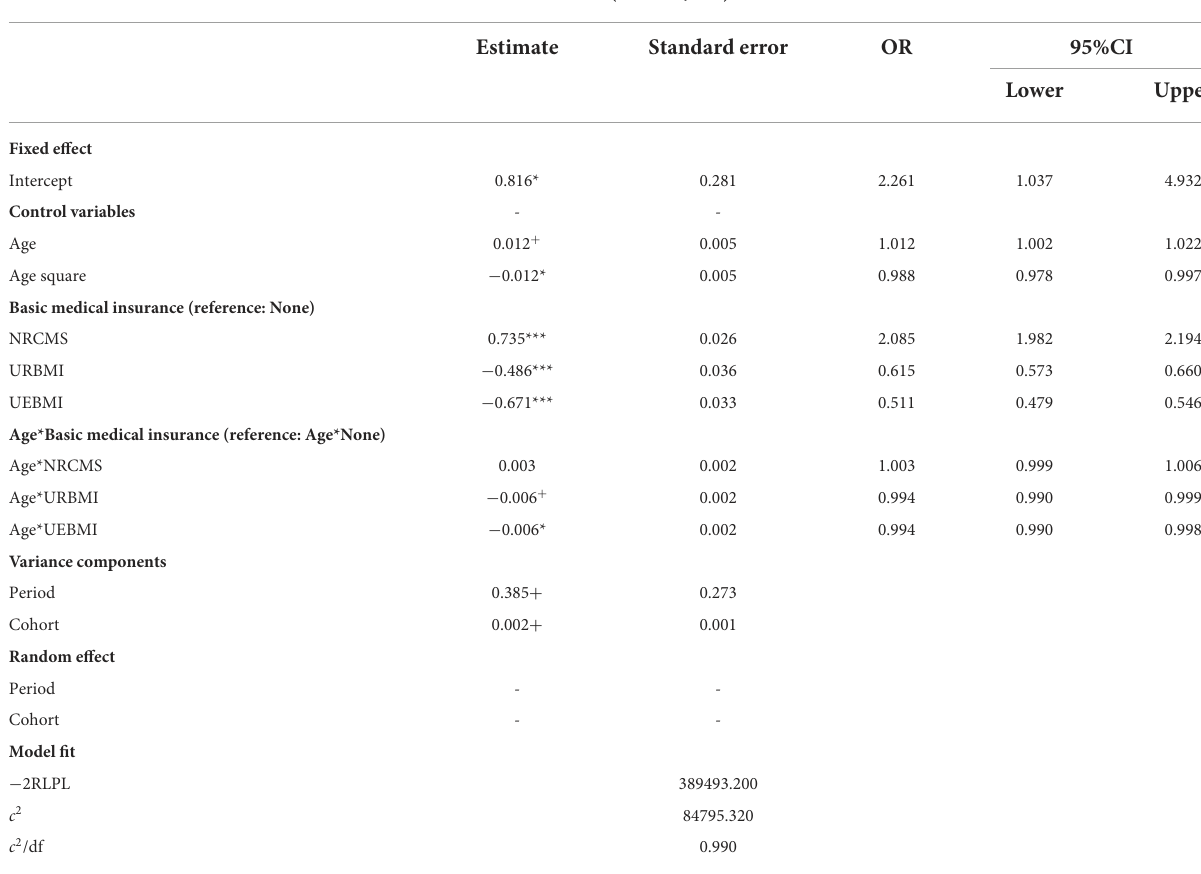
TABLE 2 The effect of basic medical insurance on behavior of seeking primary care with